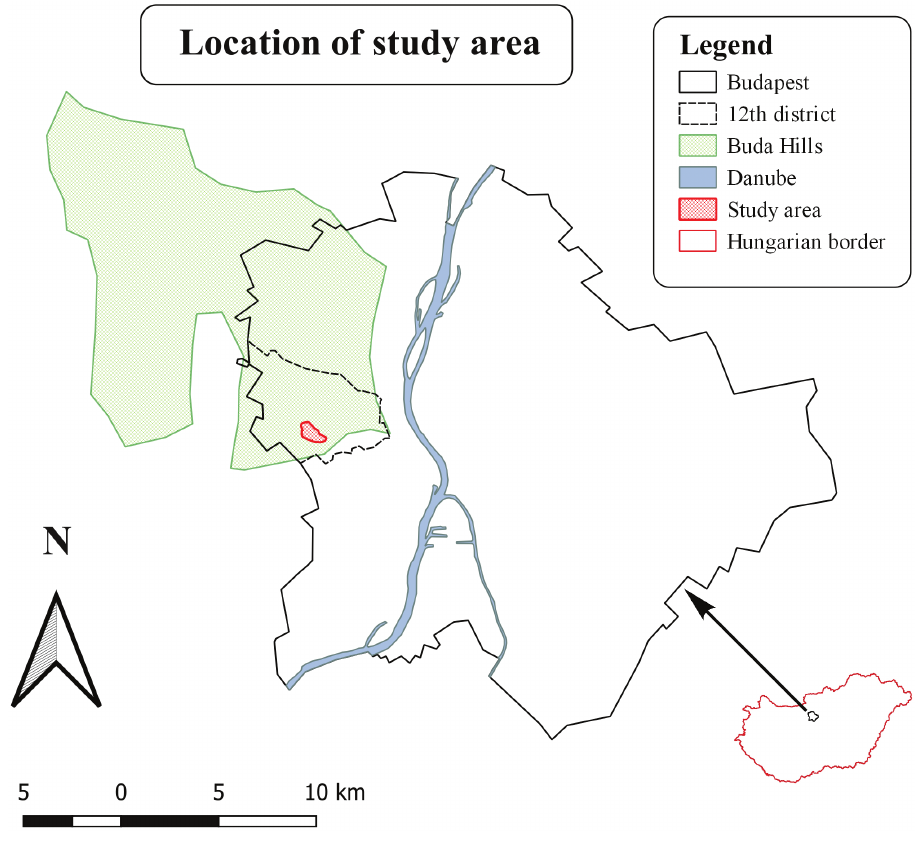
Figure 1. Location of the study